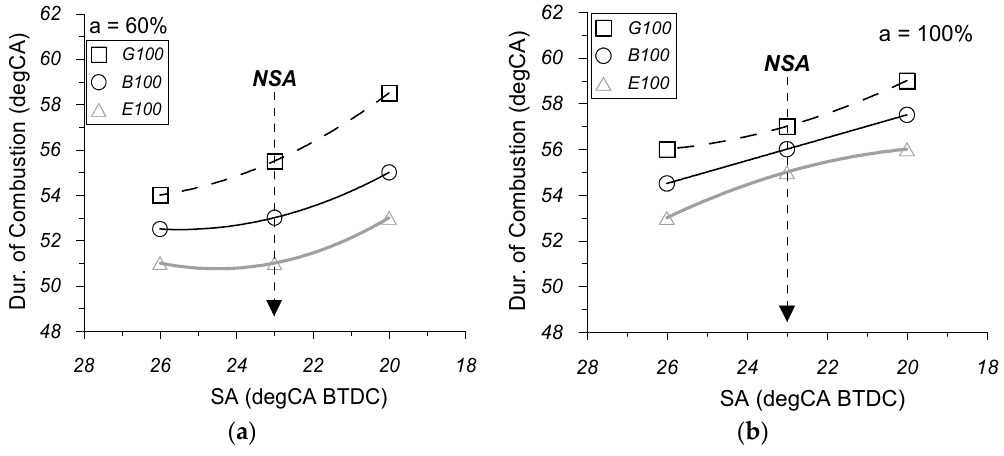
Figure 6. Variation of the calculated duration of combustion as a function of the spark advance for G100, B100 and E100 fuel operating modes, at 2400 rpm engine speed and 60% of full load ( a ); and 2400 rpm engine speed and 100% of full load ( b ).